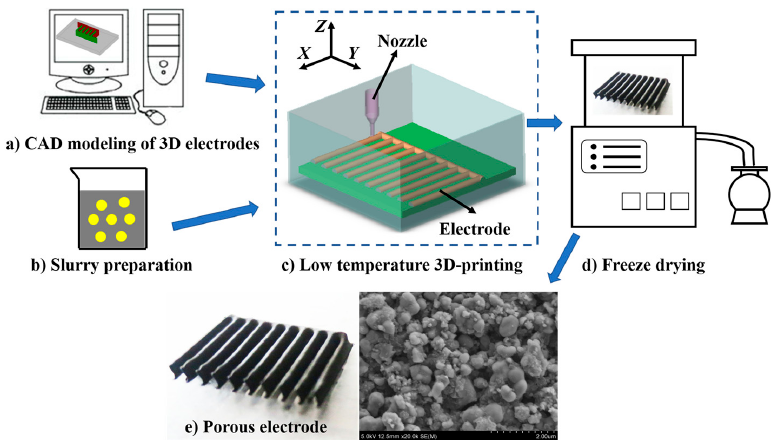
Figure 1. Fabrication process of LiFePO 4 (LFP) electrode by low temperature direct writing (LTDW). ( a ) CAD modeling of 3D electrodes, ( b ) slurry preparation, ( c ) low temperature direct writing process, ( d ) freeze-drying process, ( e ) porous electrodes.